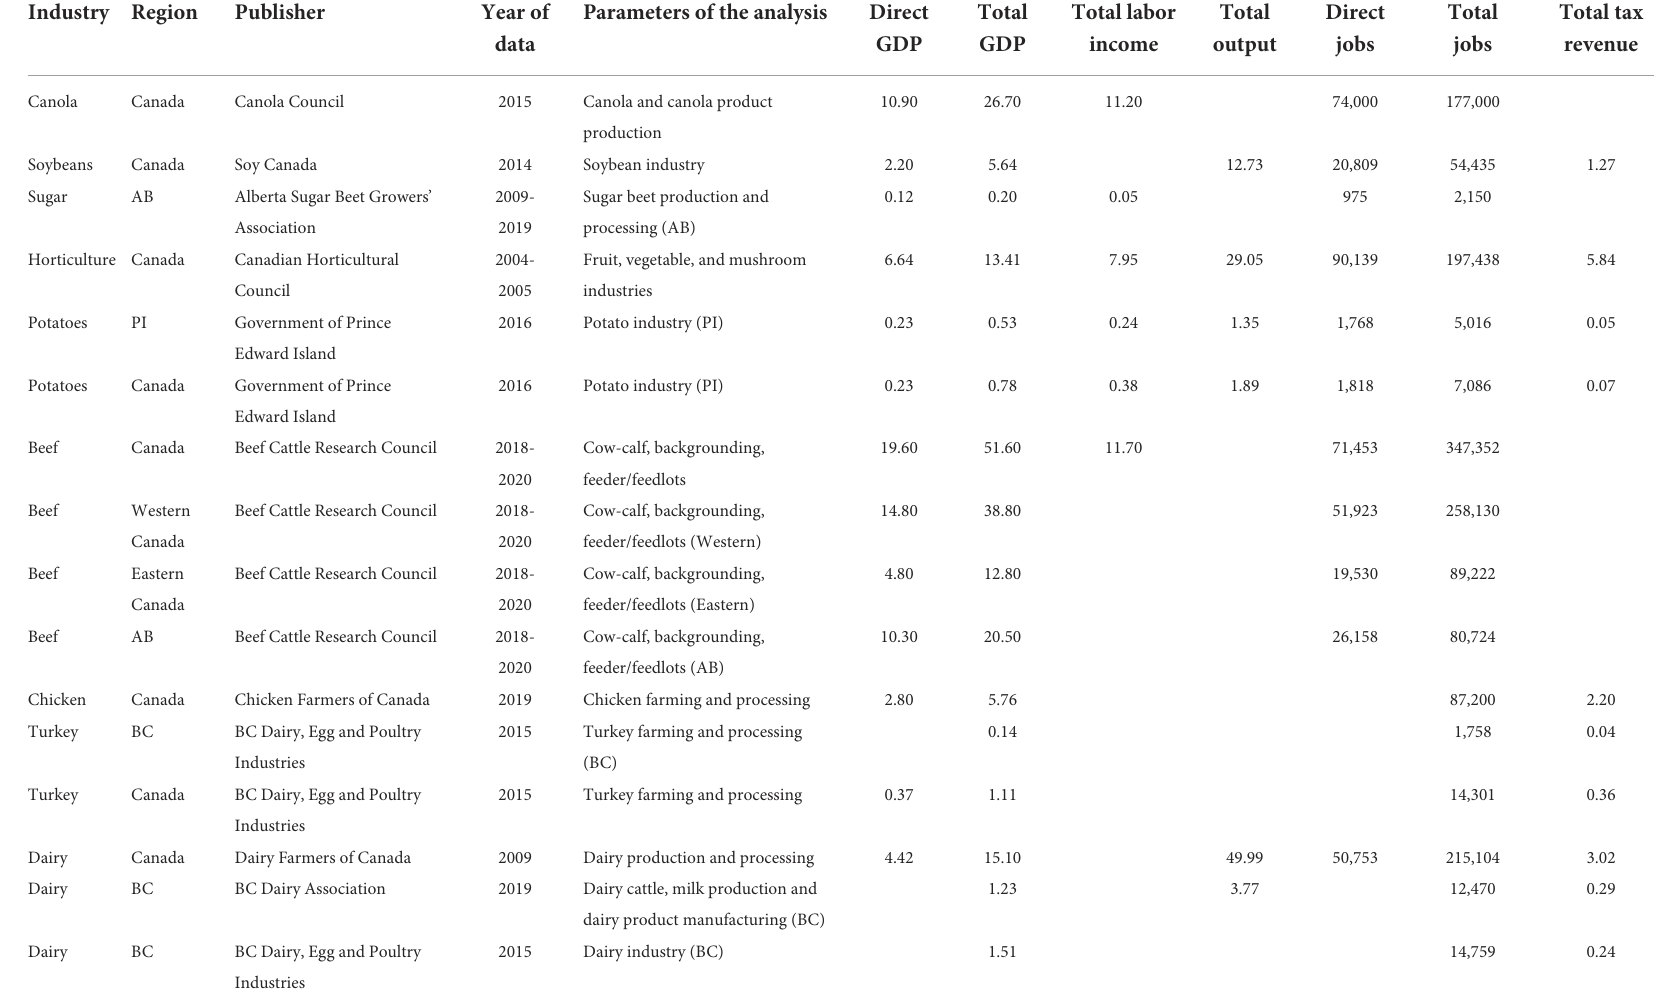
TABLE 1 Summary of input-output analyzes by industry and